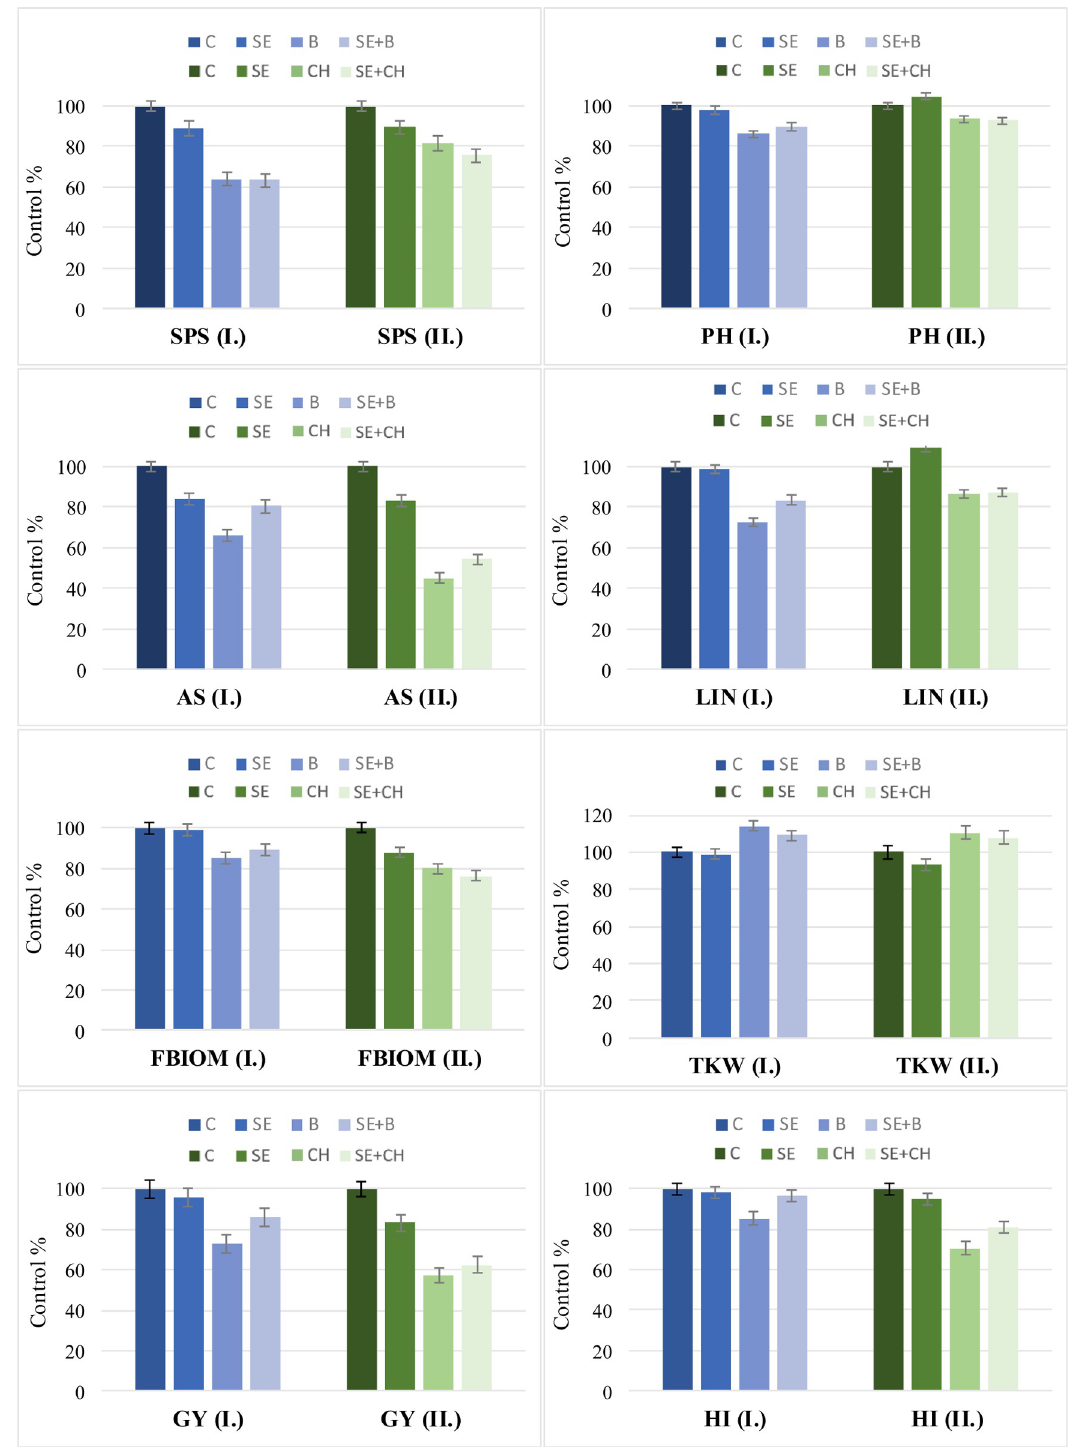
Fig 3. Effects of single and repeated heat stress treatments on various yield-related traits in two experiments. The results are averaged over 51 wheat cultivars at different developmental stages. I.: Experiment I., II.: Experiment II.; C: Control, SE: Stem elongation, B: Booting, CH: Full heading, SE+B: Stem elongation + booting; SE+CH: Stem elongation + full heading, GY: Grain yield per plant, AS: Average seed number, HI: Harvest index, TKW: Thousand kernel weight, FBIOM: Total aboveground biomass (straw + all ears), PH: Plant height, LIN: Last internode length, and SPS: Grain number per spikelet. The data are means ± LSD (n = 51). Least significant differences (LSD 5% ) denoted by bars on the columns represent significance at the P � 0.05